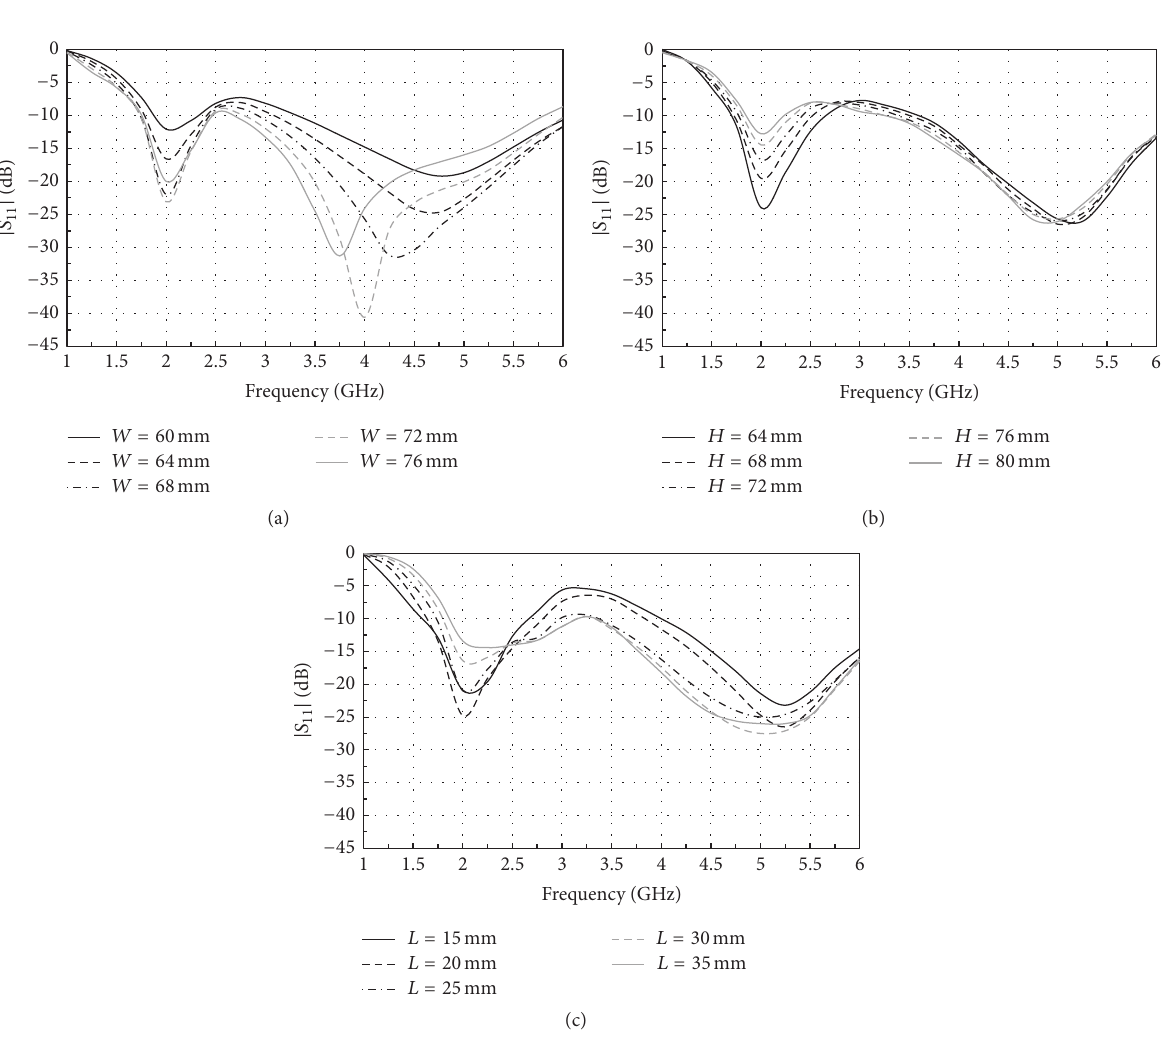
Figure 7: (a) Characteristics of |𝑆 11 | by varying 𝑊 . (b) Characteristics of |𝑆 11 | by varying 𝐻 . (c) Characteristics of |𝑆 11 | by varying 𝐿